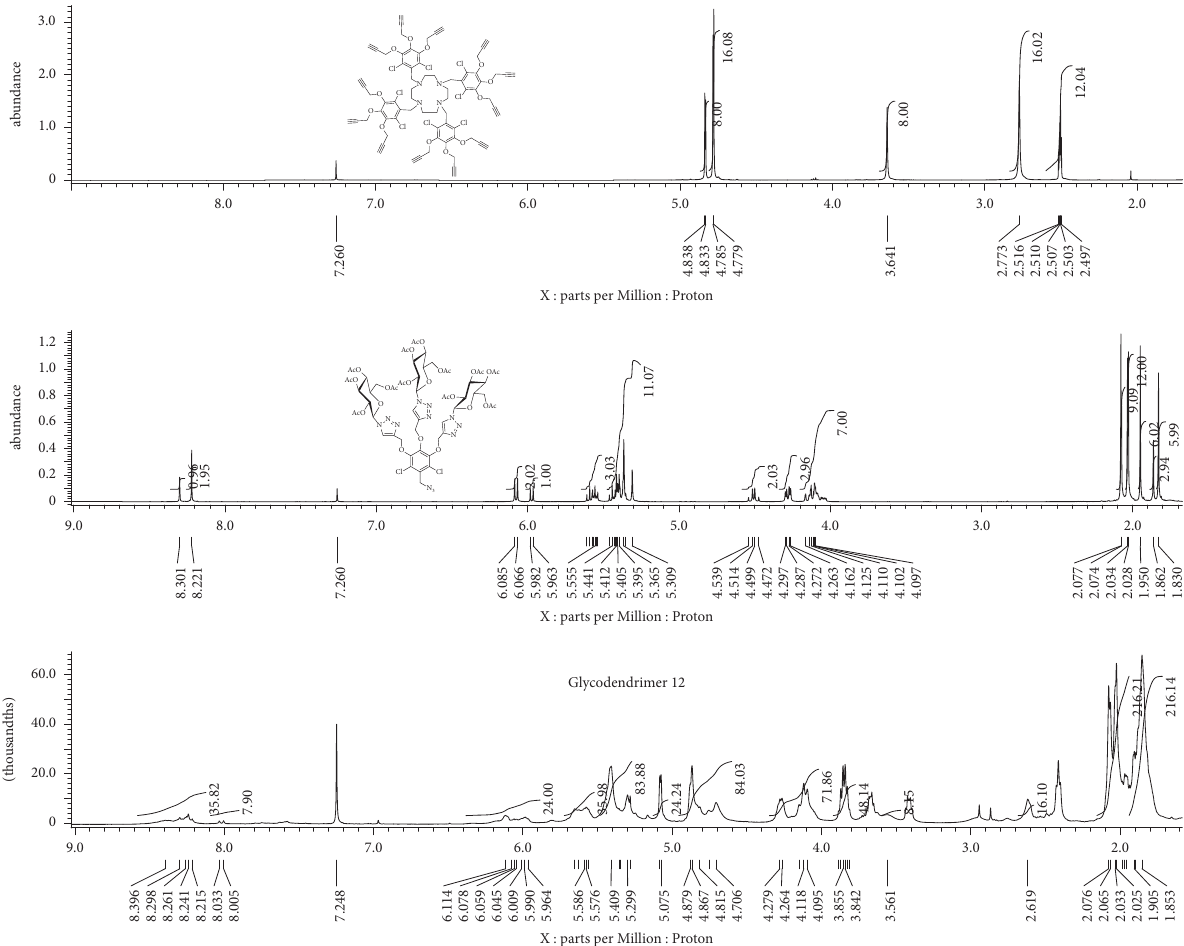
Figure 3: 1 H-NMR spectra of hypercore 7, dendritic wedge 11, and chlorine-containing glycodendrimer